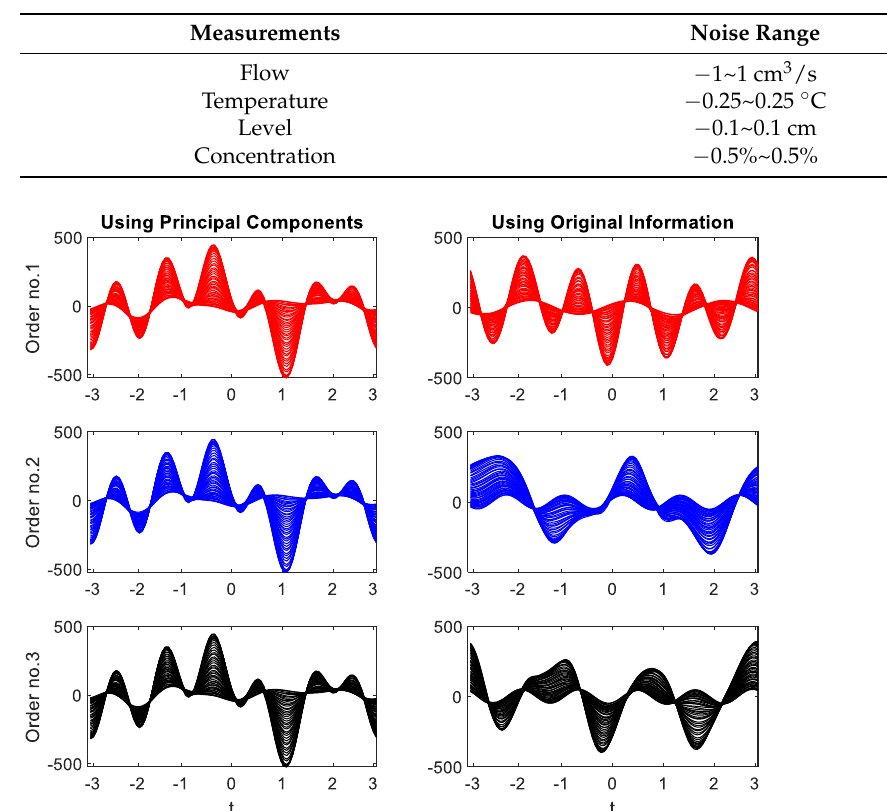
Figure 5. Results of Andrews function for the data under fault No. 7 with different variable order- ings.